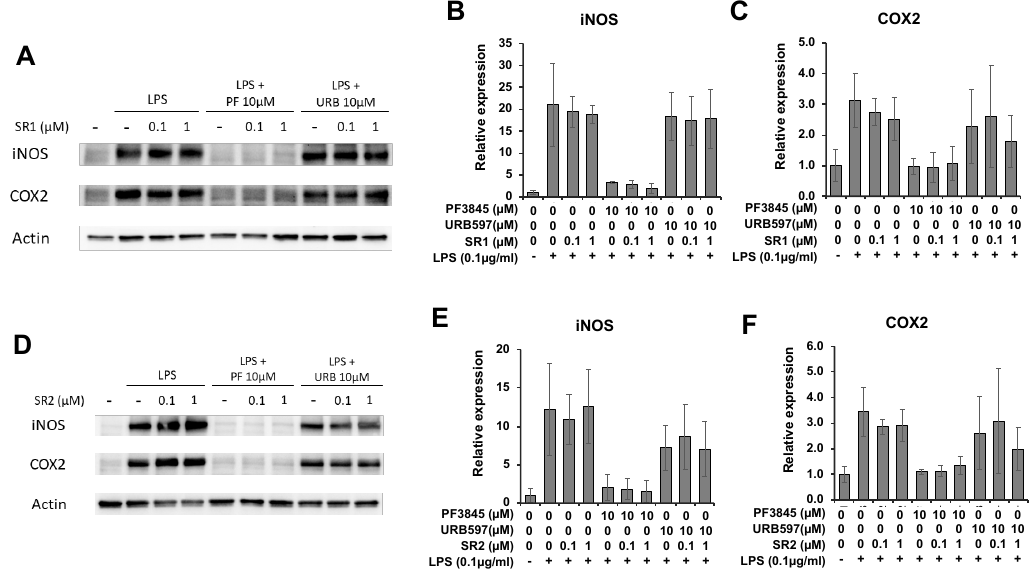
Figure 5. E ff ects of CB receptor antagonists on the FAAH inhibitor-mediated anti-inflammatory response. BV2 cells were treated with LPS, FAAH inhibitor (10 µ M), and the CB1 antagonist, SR1 (1 µ M), for 8 h. The cell lysate was used for western blotting with β -actin, iNOS, and COX-2 antibodies ( A ). The relative expression of iNOS ( B ) and COX-2 ( C ) is shown after normalizing with β -actin expression. BV2 cells were treated with LPS, FAAH inhibitor, and the CB2 antagonist, SR2 (1 µ M), for 8 h, and western blotting was performed for iNOS and COX-2 together with β -actin ( D ). Relative expression levels are shown for iNOS in ( E ) and COX-2 in ( F ). The + and – symbols indicate the presence or absence, respectively, of LPS. Data are presented as means ± S.D. (n =